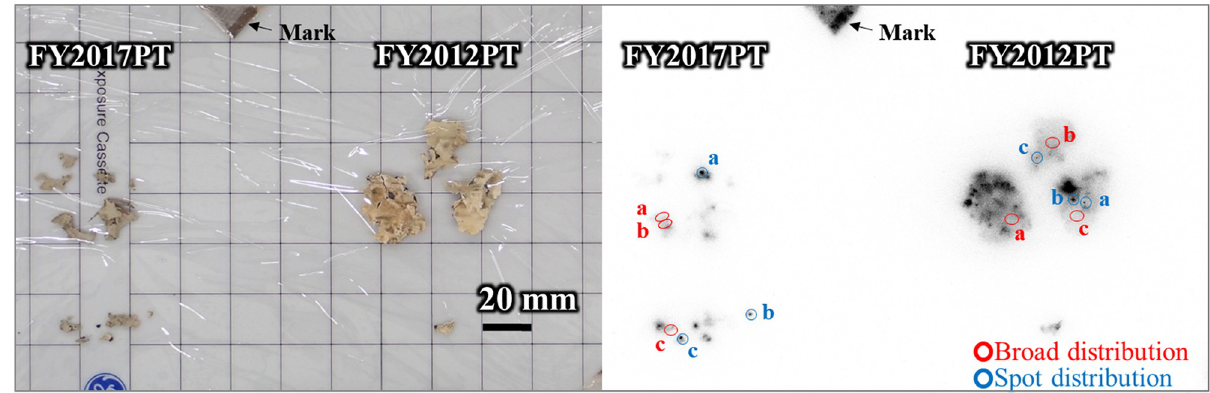
Fig 1. Radiocaesium distributions in P . tinctorum collected in FY2012 and FY2017. Autoradiograms. Left panel: images of FY2012PT and FY2017PT lichen samples. Right panel: autoradiograms of samples after 16 hours of exposure. Red circles and blue circles indicate typical broad distribution and spot distribution patterns, respectively. Each area marked “a” was used for preparation of the tissue sections.